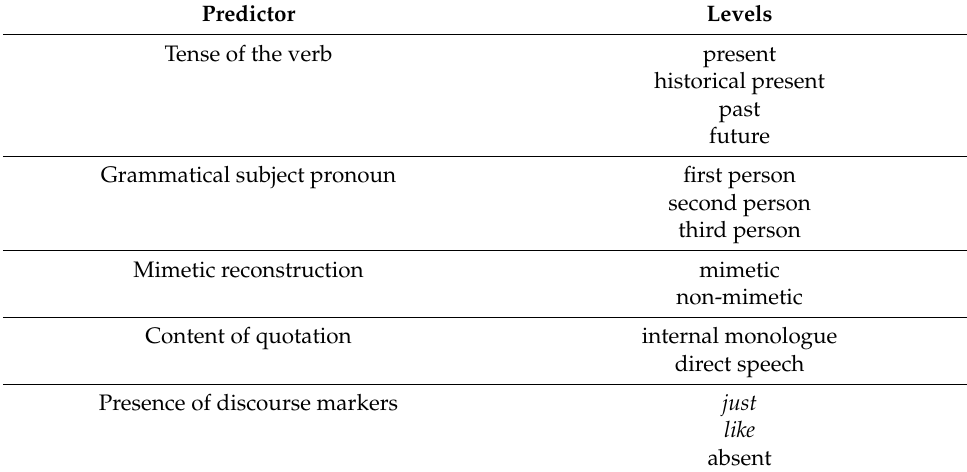
Table 2. Linguistic factors to be